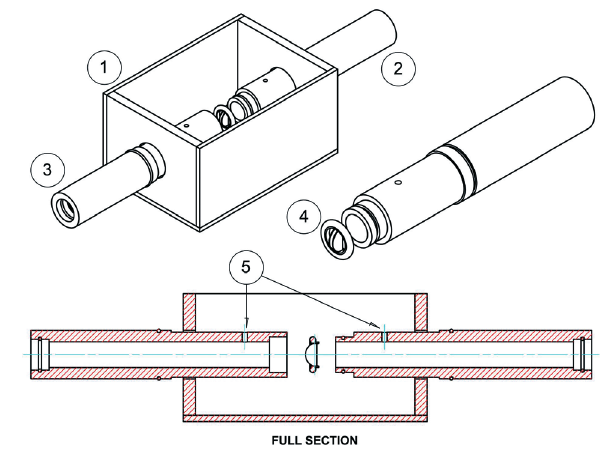
Fig. 2 - Workbench test chamber detail Highlighted: 1 (optical confinement), 2 (upstream pipe), 3 (downstream pipe), 4 (bi-leaflet mechanical heart valve) and 5 (holes for differential pressure